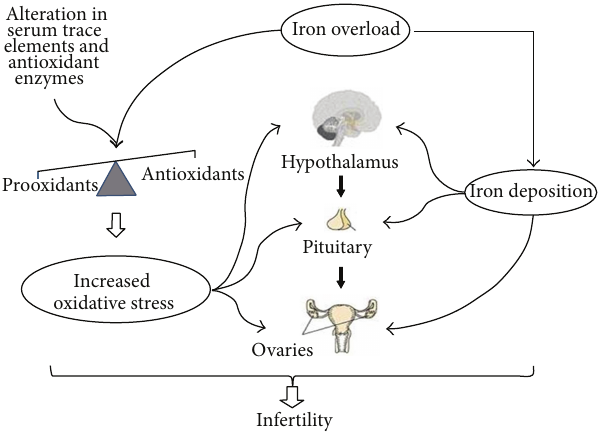
Figure 1: Infertility in female patients with BTM seems to be originated mainly by the direct and the indirect effect of iron overload. The combined effect of iron deposition and increased OS (because of a significant prooxidants/antioxidants imbalance) results in the dysfunction of the female reproductive